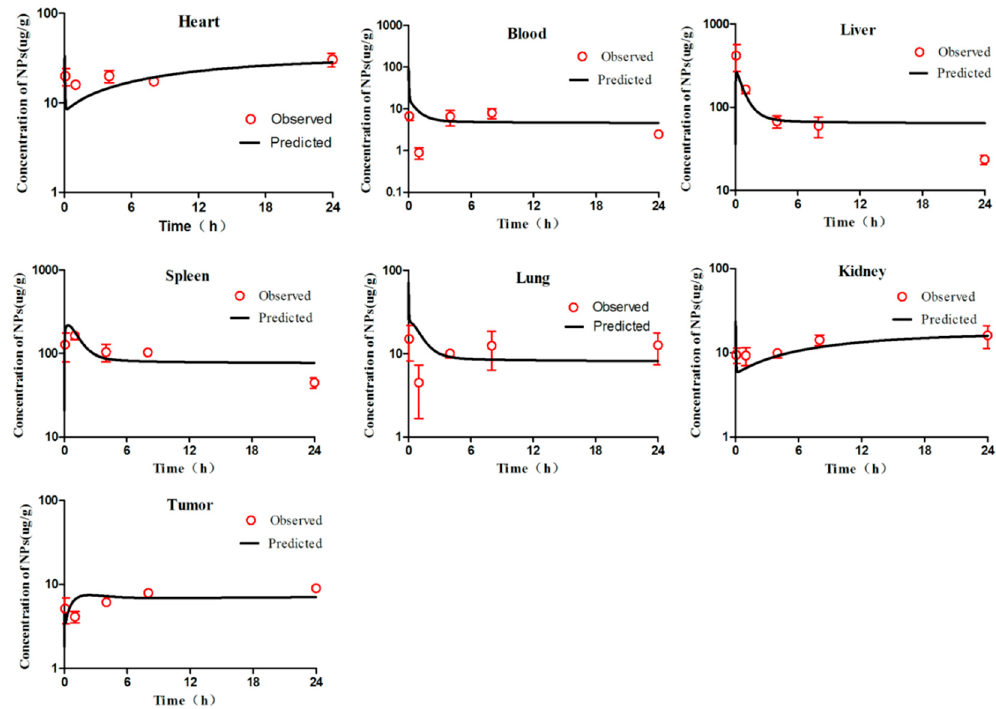
Figure 4. Simulated and experimentally measured concentration–time curves of mPEG5k-9.09%-200 nm NPs in murine blood and tissues after intravenous injection.